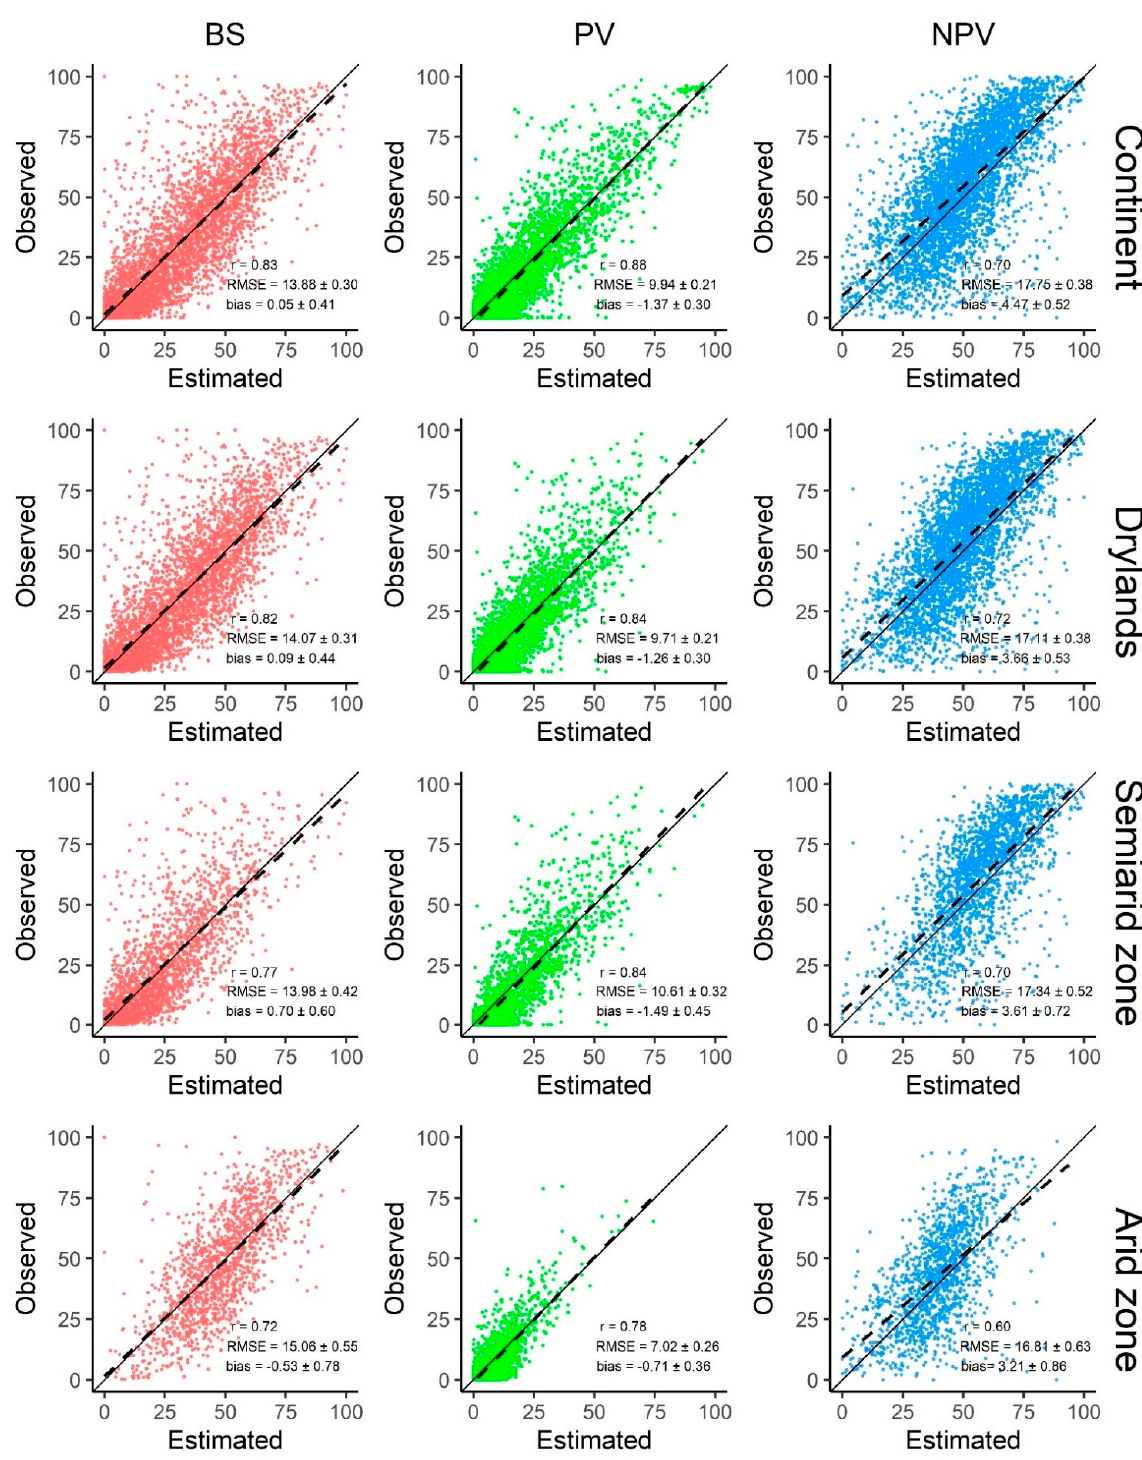
Figure 5. Scatterplots showing the field-observed (y-axis) and JRSRP-modelled (x-axis) fractions (%) of bare soil ( left ), photosynthetic vegetation ( middle ) and non-photosynthetic vegetation ( right ) for the Australian continent (n = 4207), drylands within Australia ( n = 3876) and two of its subtypes: the semi-arid zone ( n = 2116) and the arid zone ( n = 1425). The black line corresponds to the 1:1 agreement, the dashed line is the linear fit between the observed and predicted values. Pearson’s correlation coefficient (r), root mean square error (RMSE), and bias (calculated as the mean difference between observed and predicted) are displayed. Confidence intervals of 95% are shown for RMSE and